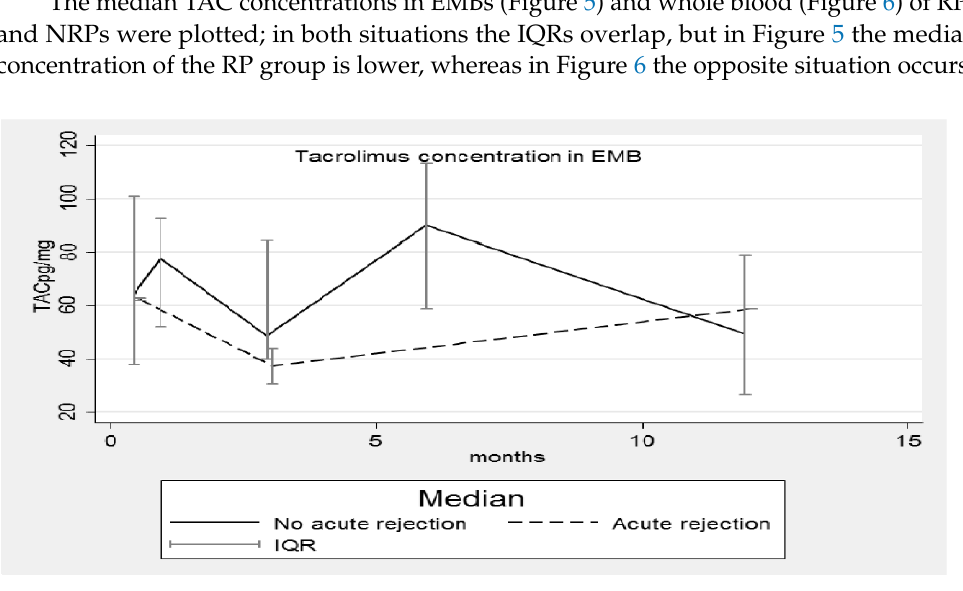
Figure 6. Median concentration–time profile of Tacrolimus in whole blood with and without acute rejection episodes. IQR: interquartile range. No correlation was found between TAC concentrations in EMBs and whole blood, considering all patients together as a single group and as subgroups of RPs or NRPs. 4. Discussion and Conclusions Despite the progress and improved overall outcomes, acute allograft rejection (AR) remains the Achilles’ heel of heart transplantation. The manifestations of rejection can oc- cur as early as intraoperatively to many years after transplant. The timing of AR plays a significant role in establishing cause and diagnosis. Acute rejection can either be respon- sible for early graft dysfunction, occurring in the first days after surgery, or late graft dys- function developing weeks to years after transplantation. Acute allograft rejection is an important contributor to graft failure, which remains a leading cause of death (10%) within the first three years after HTx; low TAC levels in